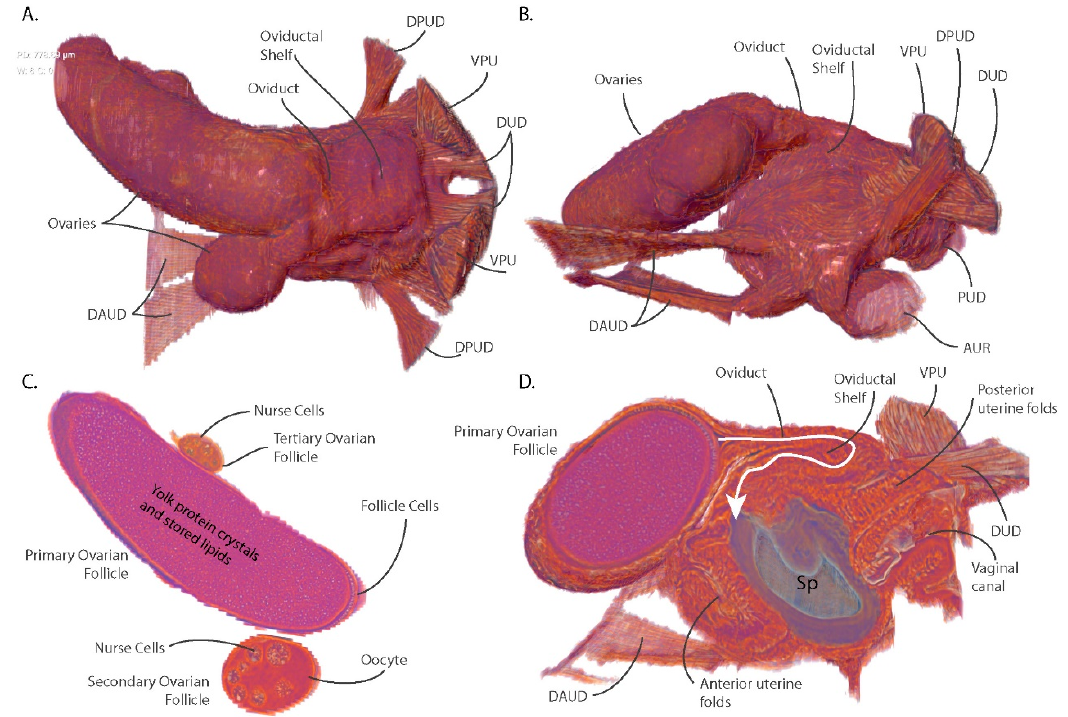
Figure 3. Views of the ovarian and uterine tissues highlighting ovarian structure, oocyte development and ovulation mechanics. ( A ) Dorsal view; ( B ) Lateral View; ( C ) Coronal section of ovarian follicles; ( D ) Sagittal section through the ovaries and uterus highlighting the path of the oviduct and the spermatophore inside the uterus. Abbreviations: DPUD—diagonal posterior uterine dilatory musculature, VPU—vertical posterior uterine musculature, DUD—dorsal uterine dilator musculature, DAUD—diagonal anterior uterine dilator musculature, AUR—anterior uterine retractor musculature.